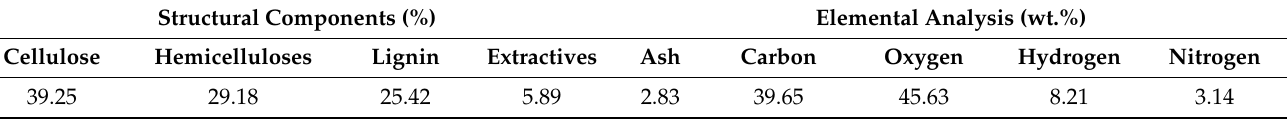
Table 1. Characteristics of the RS sample.